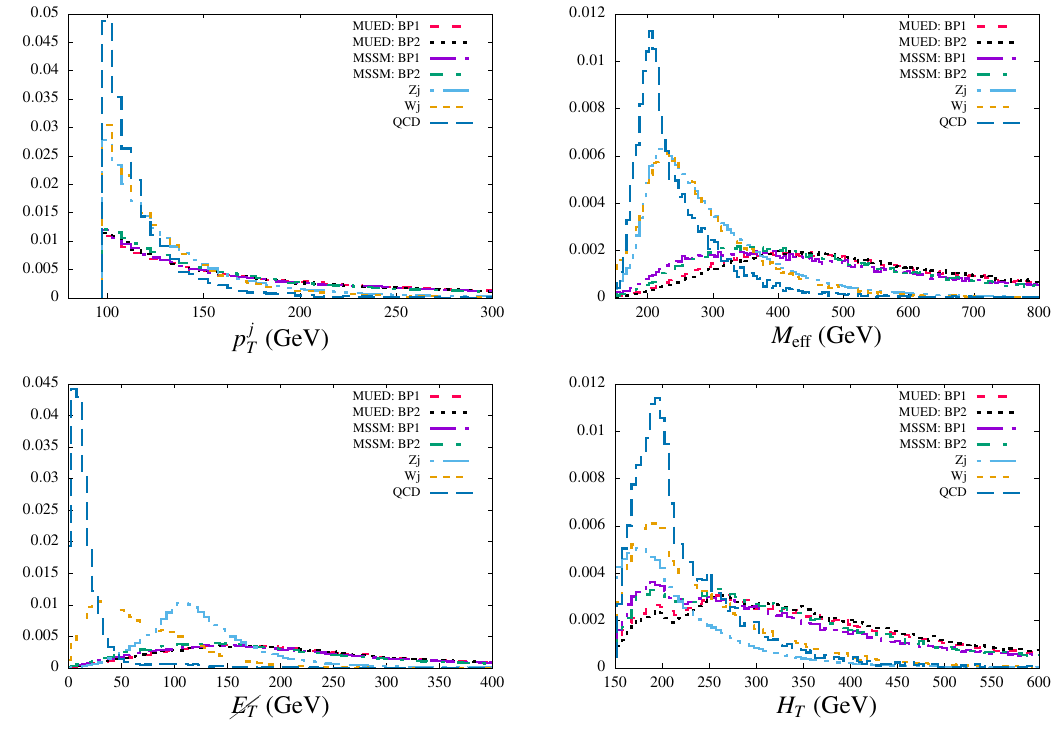
Figure 2 . Top row: normalized distributions of the p T of the leading jet and M e(cid:11) are plotted for the relevant SM backgrounds and four signal benchmark points corresponding to MUED and MSSM as shown in table 1. Bottom row: normalized distributions of (cid:26) (cid:26) E T and H T are shown for the same set of